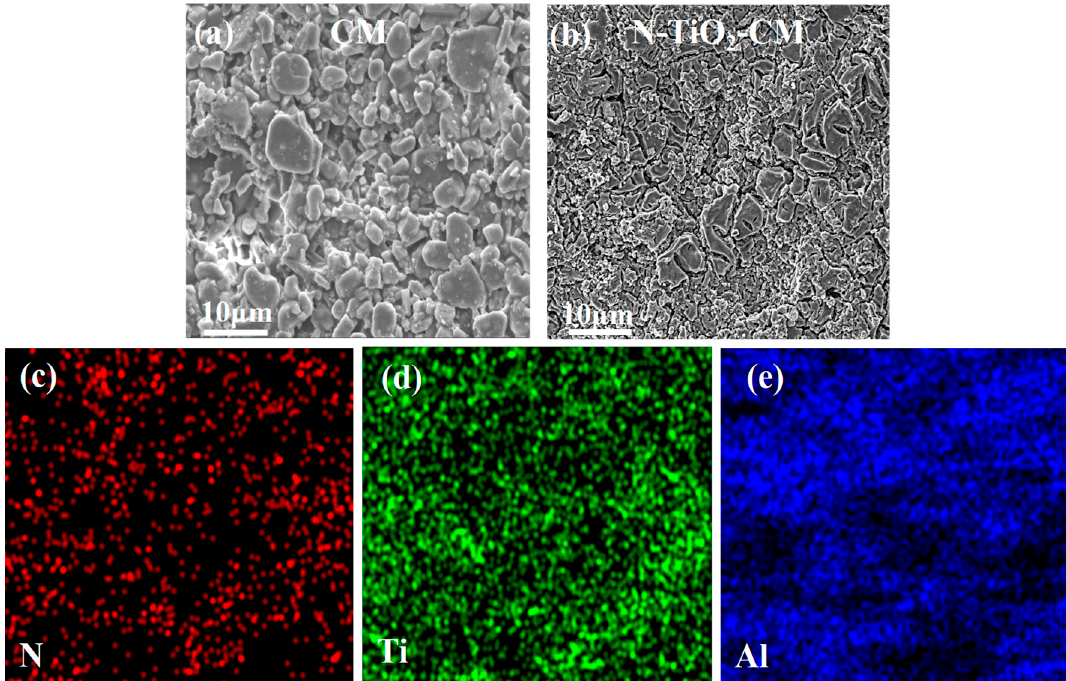
Figure 5. The SEM images of the CM ( a ) and N-TiO 2 -CM ( b ). The EDS images of the N ( c ), Ti ( d ) and Al ( e ).